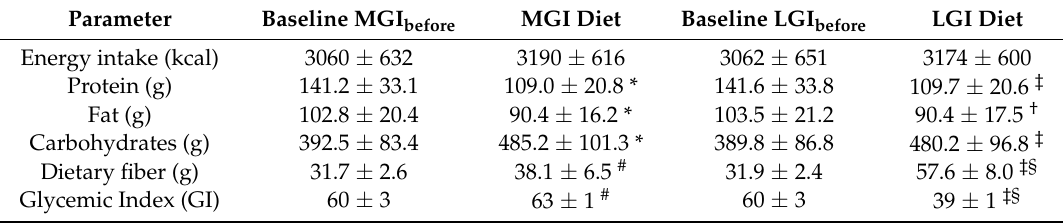
Figure 1. A flow chart of the study design. Abbreviations: GI—glycemic index, MGI—moderate glycemic index, LGI—low glycemic index. Table 1. Composition of the baseline, moderate glycemic index (MGI), and low glycemic index (LGI)